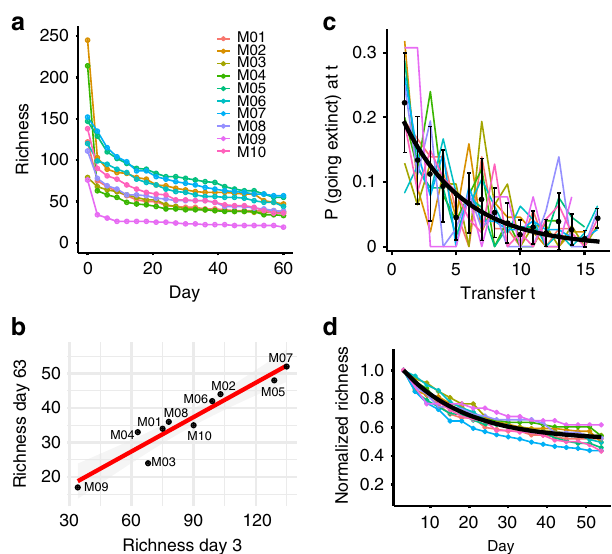
Fig. 2 Early richness predicts fi nal richness and communities equilibrate at a common rate. a Richness over time for each microcosm community. b Richness on Day 3 (1st timepoint) is strongly correlated with richness on Day 63 (21st timepoint). Linear model: R 2 = 0.9008, p = 1.714 × 10 − 5 . c The probability of going extinct at transfer t . Colored lines are probability densities for individual microcosms. Black points are averages across microcosms, the black line is the maximum likelihood distribution with a common parameter across microcosms (see main text and Methods) given by the inverse mean extinction time. d Richness over time for each microcosm community, normalized by the richness on Day 3. The black line shows the exponential decay curve parametrized by the mean proportion of surviving ASVs (from b ) and the common ASV extinction rate (from c fi ltered microcosms were indistinguishable in an NMDS visua- lization of their assembly dynamics (Supplementary Fig. 2b).